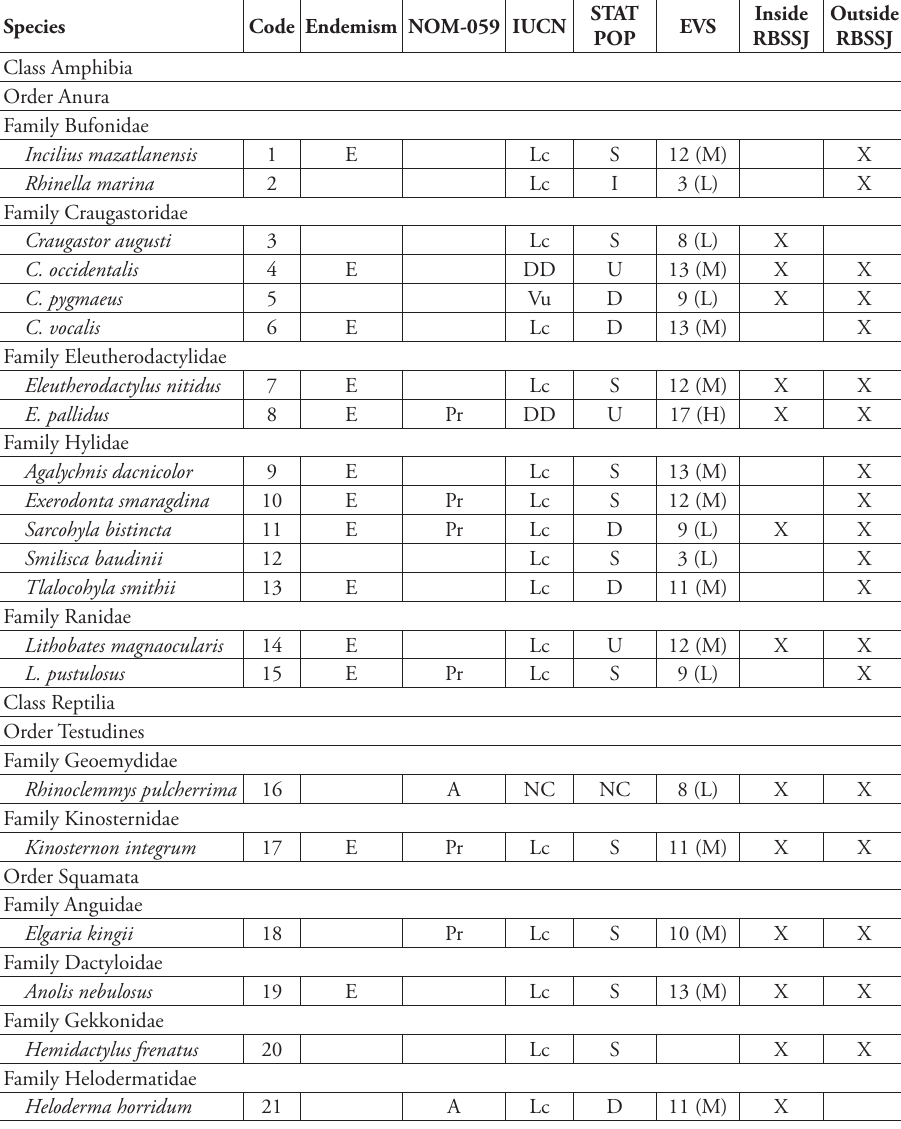
Table 1. List of species of amphibians and reptiles of Sierra San Juan, Nayarit, and Biosphere Reserve Sierra San Juan (RBSSJ) (X = occurrence). The code of each species used in the curves of rank-abundance (Code) is provided. Also, E = endemic to Mexico, protection category according to the Mexican Official Standard NOM-059 (Pr = Special protection, A = endangered), and International Union for Conserva- tion of Nature (IUCN, Lc = Leas Concern, Dd = Deficient data, V = Vulnerable, NT = Near Threatened, NC = Not Consider), are provided. The population status (STAT POP; S = Stable, I = Increasing, U = Unknown, D = Decreasing, NC = Not Consider) and the value of environmental vulnerability index ac- cording to Wilson et al. (2013a, b) (EVS for its acronym in English; L = low [3-9], M = medium [10-13], H = high [14-20]; ?= not tested) are